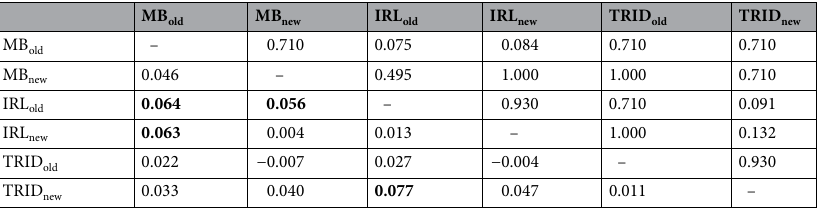
Table 3. Pairwise distance between sampling sites. Cells in bold indicate moderate genetic differentiation (0.05 < F ST < 0.15) 47 . Cells below diagonal show pairwise F ST values. Values above diagonal show estimated p-values obtained from bootstrapping after correcting for multiple